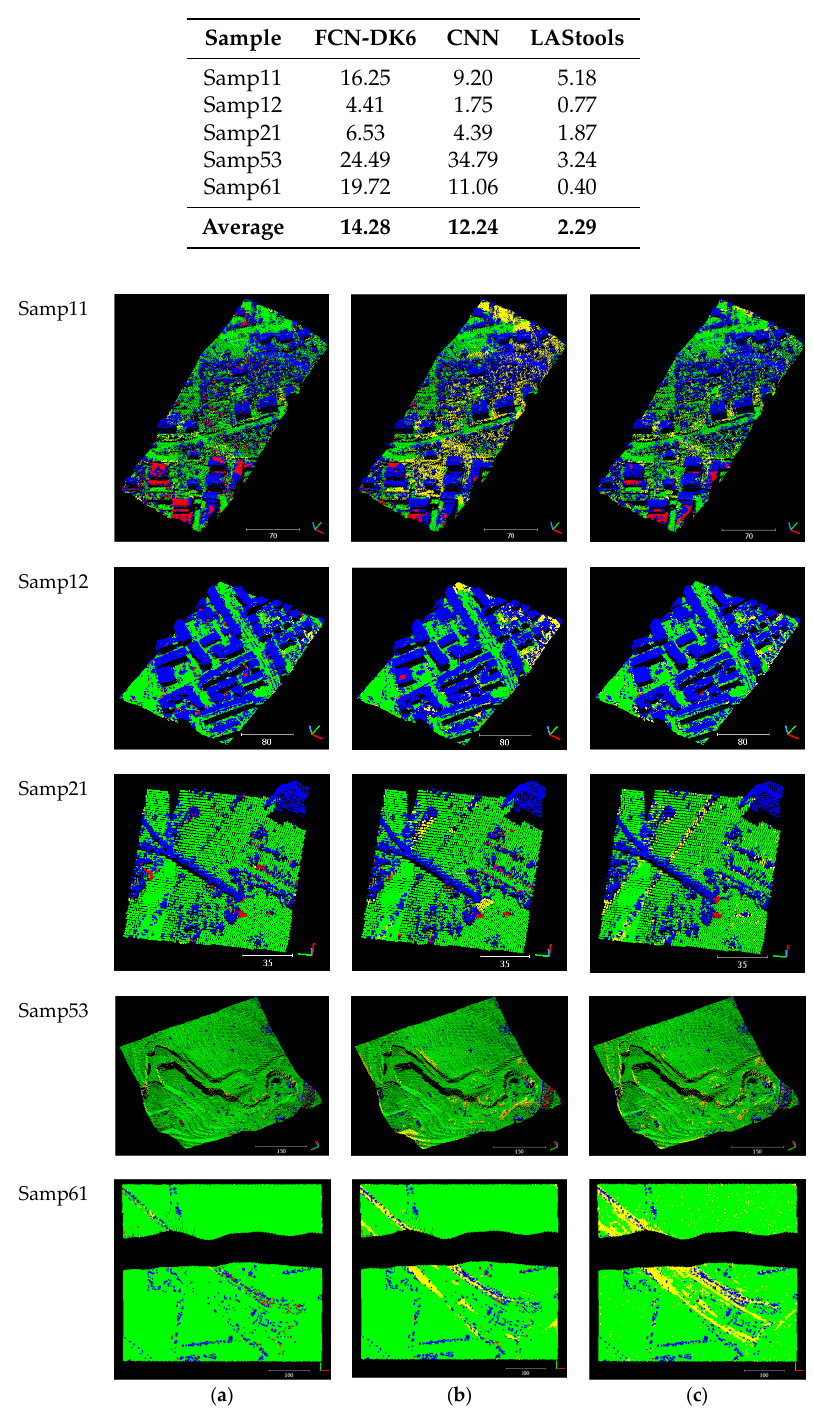
Figure 8. Results on five testing samples of the ISPRS dataset: ( a ) FCN-DK; ( b ) Convolutional Neural Network (CNN); ( c ) LAStools software. Green: correctly labeled ground; Blue: correctly labeled non-ground; Yellow: ground point misclassified as non-ground; Red: non-ground point misclassified as ground.